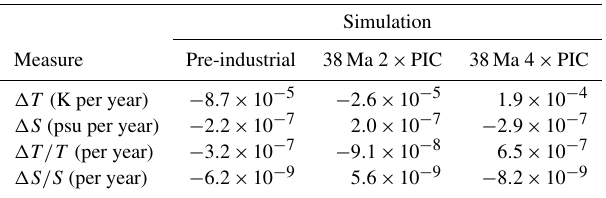
Table 2. Overview of drifts in globally averaged (full-depth, volume-weighted) ocean temperature and salinity over the last 200 model years for all three CESM spin-up simulations. Normalised drifts (cid:49)T/T and (cid:49)S/S , with T temperature in Kelvin and S salin- ity in practical salinity units (psu), are also shown for each case using the same